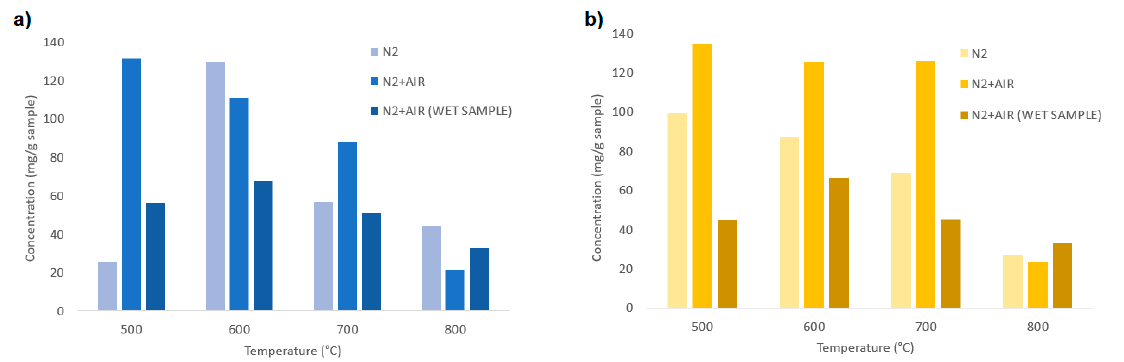
Figure 12. Total aromatic hydrocarbons for different temperatures (500, 600, 700, 800 °C) and fluidizing agent (N 2 , N 2 +air, N 2 +air-wet sample); ( a ) chirurgical masks; ( b ) FFP2 masks.